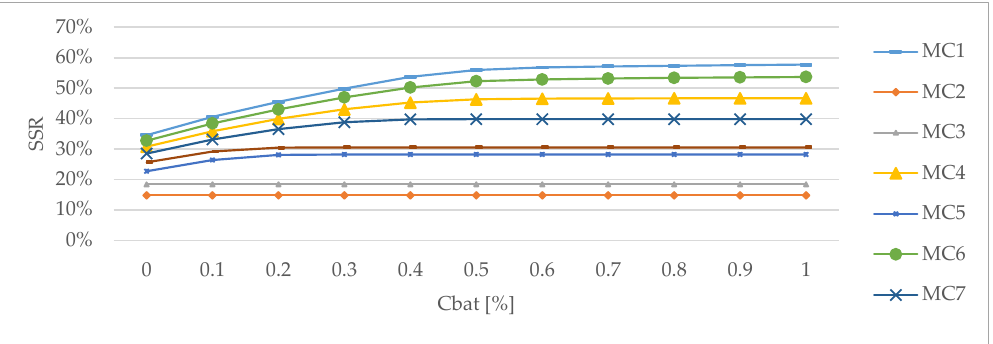
Figure 14. Comparison between the capacity of the storage system and the SSR for the MC.